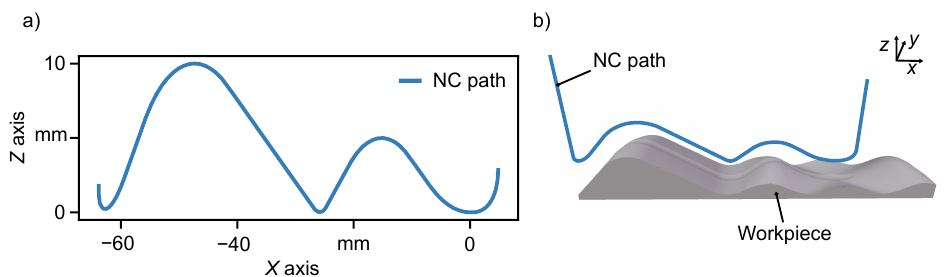
Figure 10. Analysed NC path for optimisation: ( a ) in X- and Z-coordinates and ( b ) in the GPS, showing the prepared workpiece